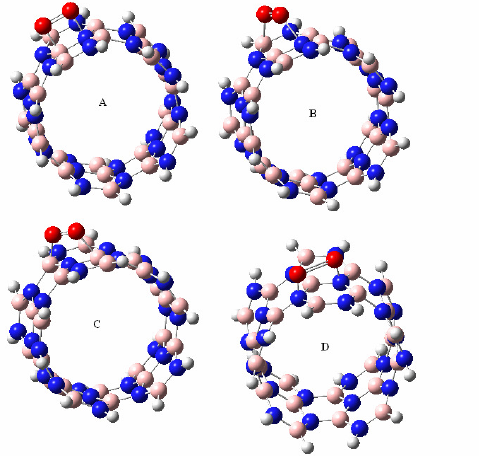
Figure 3 . Four chemisorption states of an O